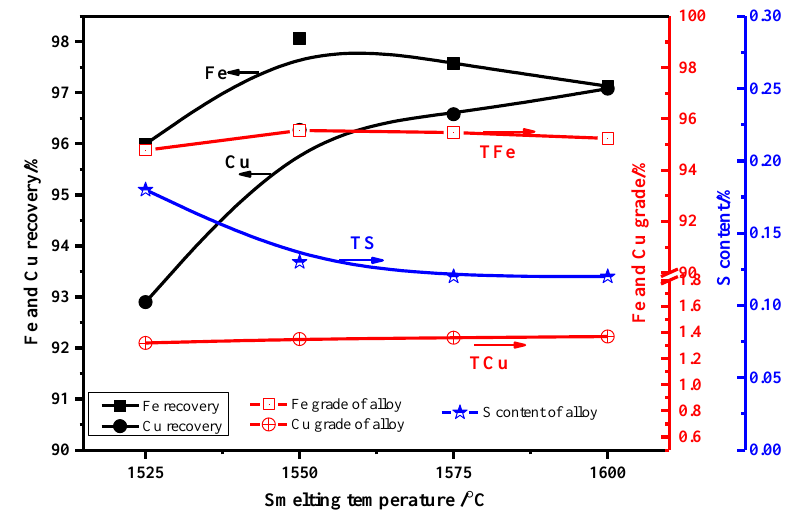
Figure 5. E ff ect of smelting temperature on Fe and Cu recovery and S removal (Smelting for 30 min with 0.7 binary basicity).